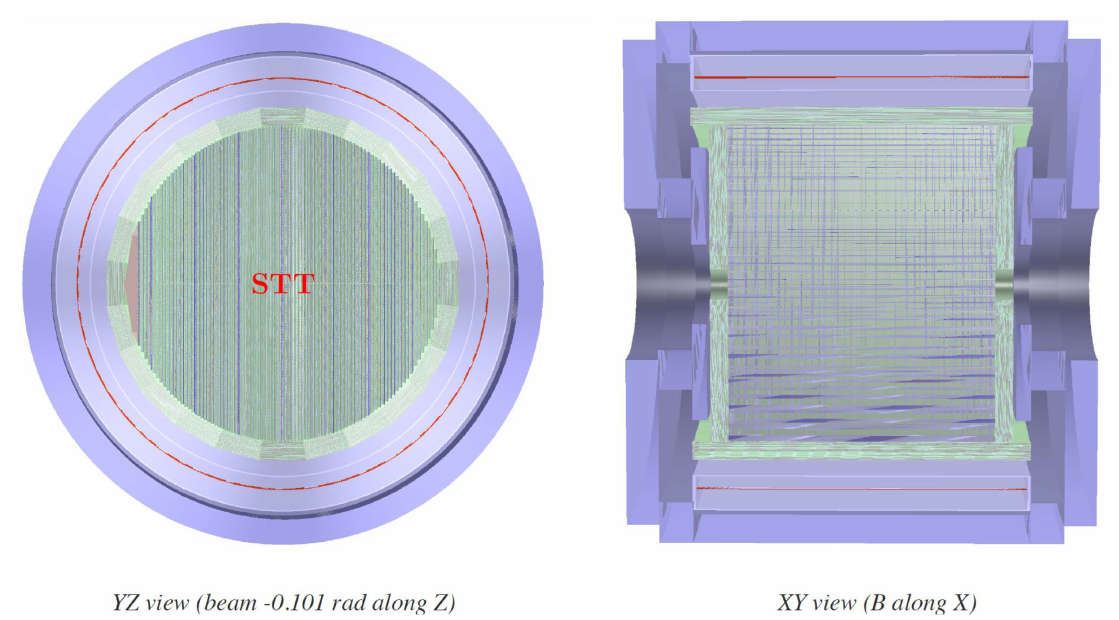
Figure 132. Geometry of the STT-only configuration for the SAND inner target/tracker. The different STT modules are visible from the YZ view on the left: the blue modules are equipped with graphite targets and are interleaved with standard CH 2 modules shown in